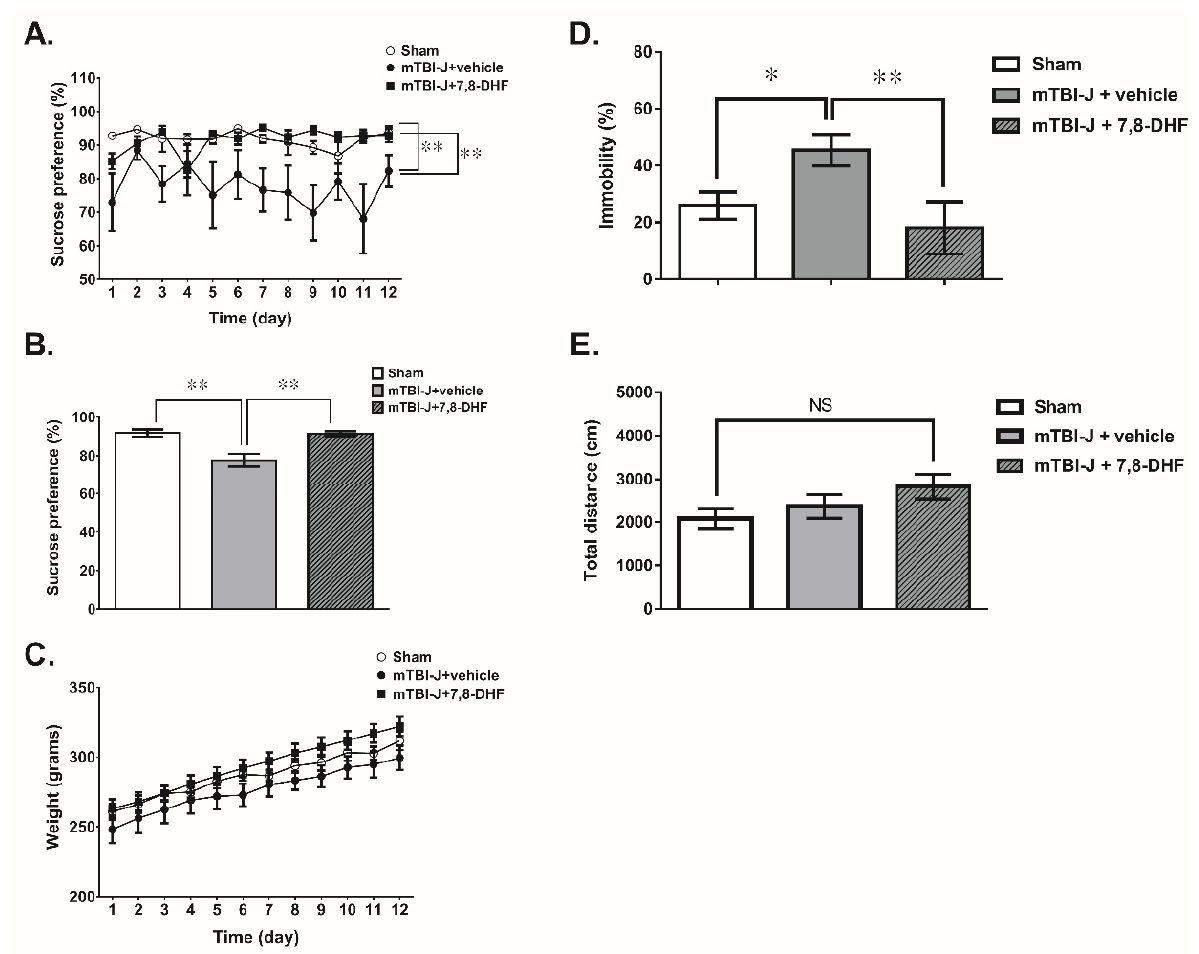
Figure 5. Chronic systemic administration of 7,8-DHF lessens the depression-like behavior of mTBI-treated animals. ( A ) The preference ratio of the mTBI-J+vehicle group in the sucrose preference test was decreased compared with the sham group (two-way ANOVA, p = 0.0016), and the 7,8-DHF treatment was restored the sucrose preference ratio compared with the corresponding mTBI-J+vehicle group animals (two-way ANOVA, p = 0.0011). ( B ) The average preference ratio was summarized. ( C ) The body weight did not differ between both groups. ( D ) The immobility in the forced swimming test was significantly increased in the mTBI-J+vehicle group animals, but the 7,8-DHF treatment has reduced the immobility. ( E ) There was no difference in the locomotor motor distance in both groups (unpaired t -test, p = 0.4386, N = 10 per sham and mTBI-J+7,8-DHF group groups). Data was showed as mean ± SEM (NS: no significance, * = p < 0.05, ** = p <